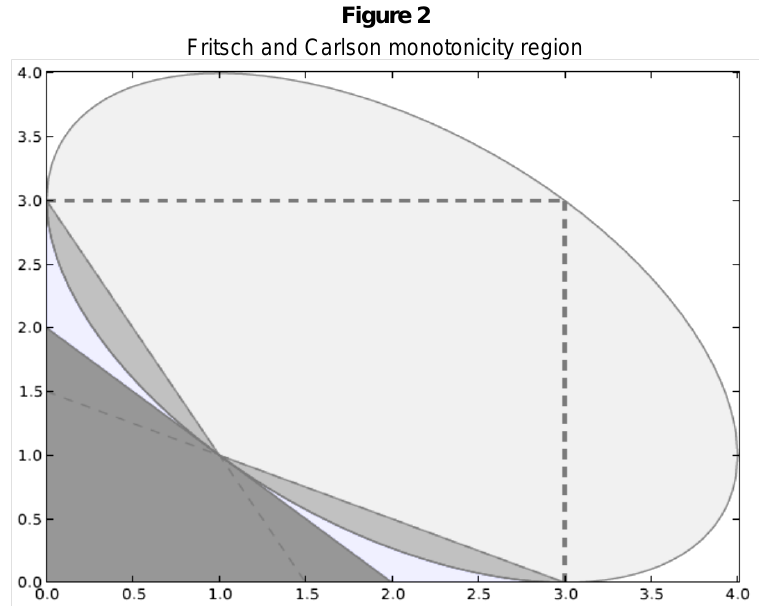
Fritsch and Carlson monotonicity